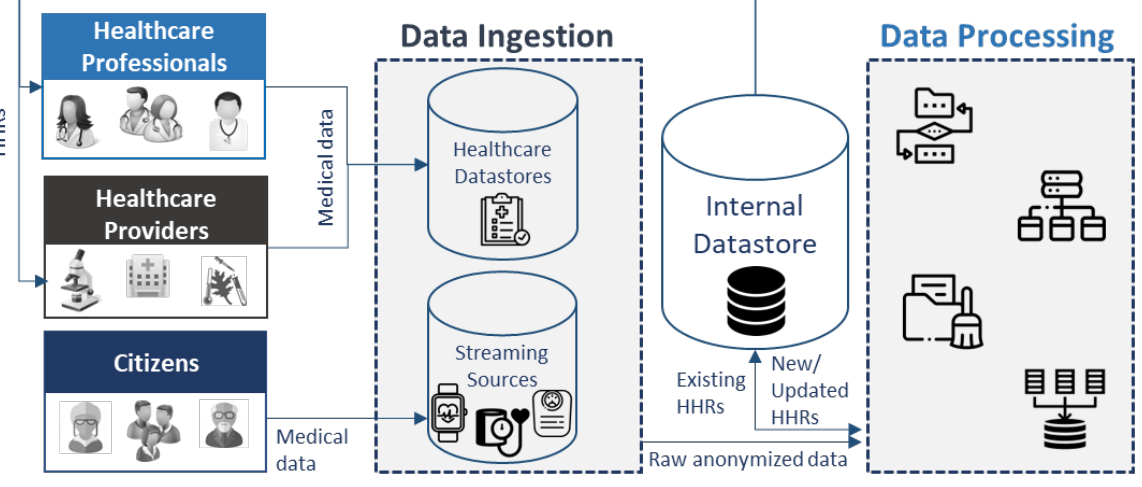
Figure 3. Involved